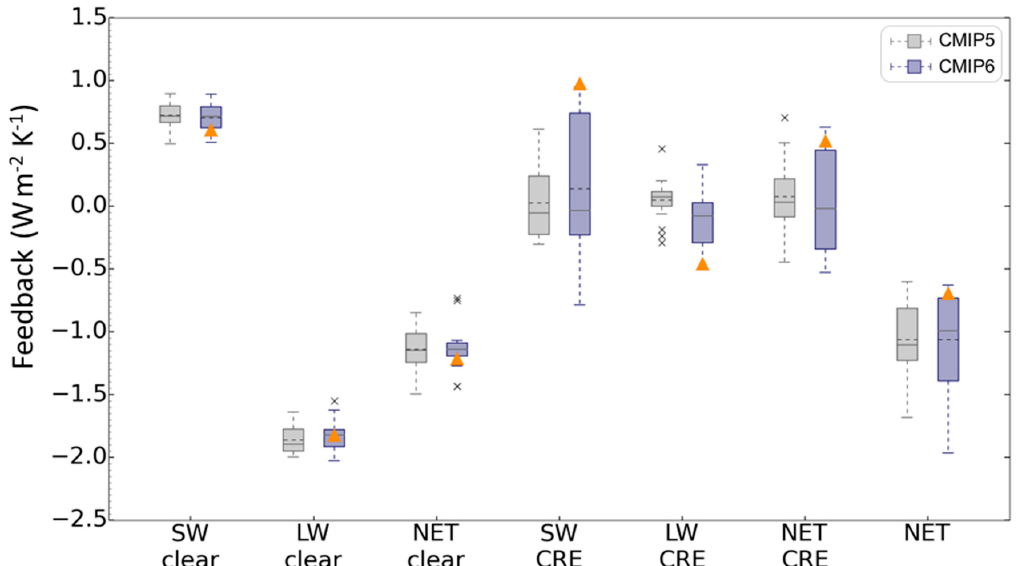
Figure 3. Global mean radiative feedback components in Wm − 2 K − 1 derived from K-ACE (orange triangle), the CMIP5 (gray boxplots), and CMIP6 (blue boxplots) multi-model ensemble. Types of feedback are clear sky (shortwave; SW, longwave; LW, and net; NET), cloud radiative effect (SW, LW, and NET), and the total feedback. The box plot indicates the total range, quartile range, mean (gray dotted line), and median values (gray line). The orange triangles indicate K-ACE.